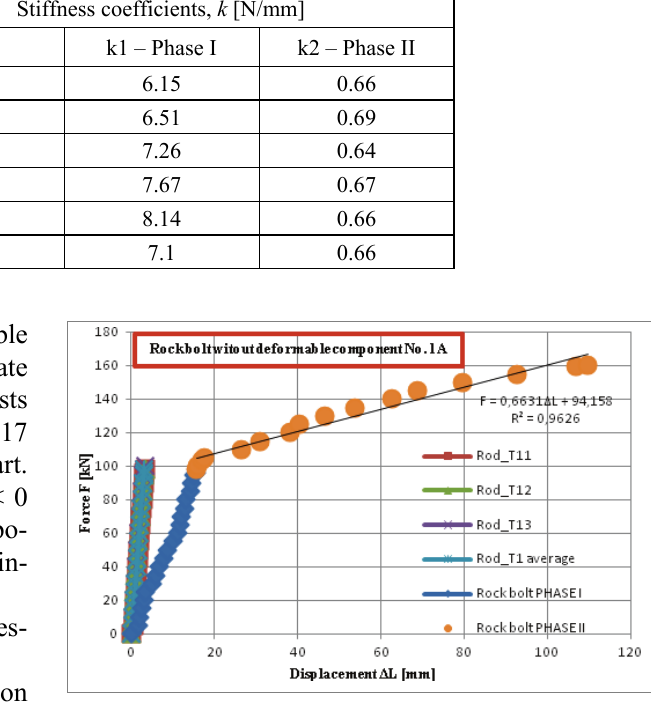
Fig. 26. Full loading characteristics for the rock bolt No. 1A